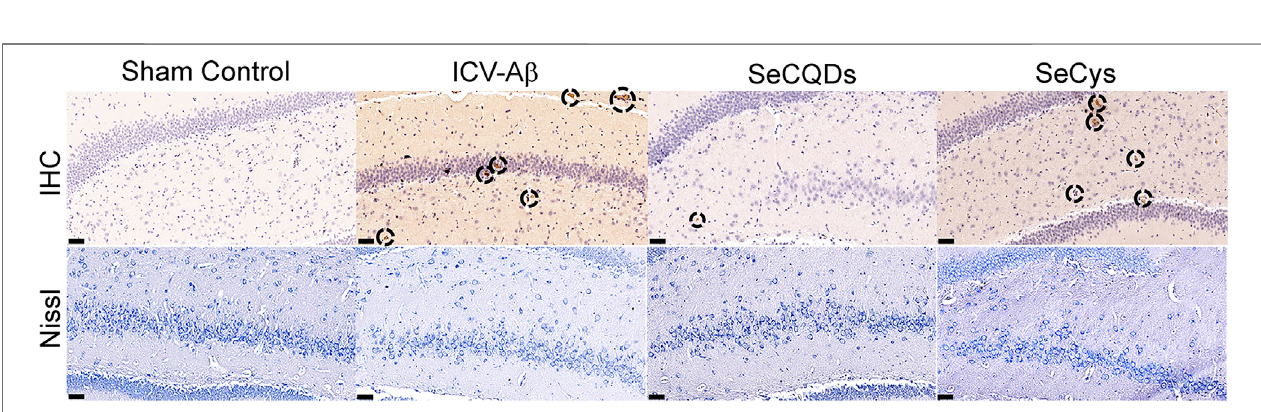
FIGURE 9 | The IHC analysis of A β deposition (upper) and the Nissl staining of nerve cells (down) in the brains of sham control rat, A β 40-infused rat, A β 40-infused rat treated with SeCQDs and SeCys. Scale bars are 50 μ m.